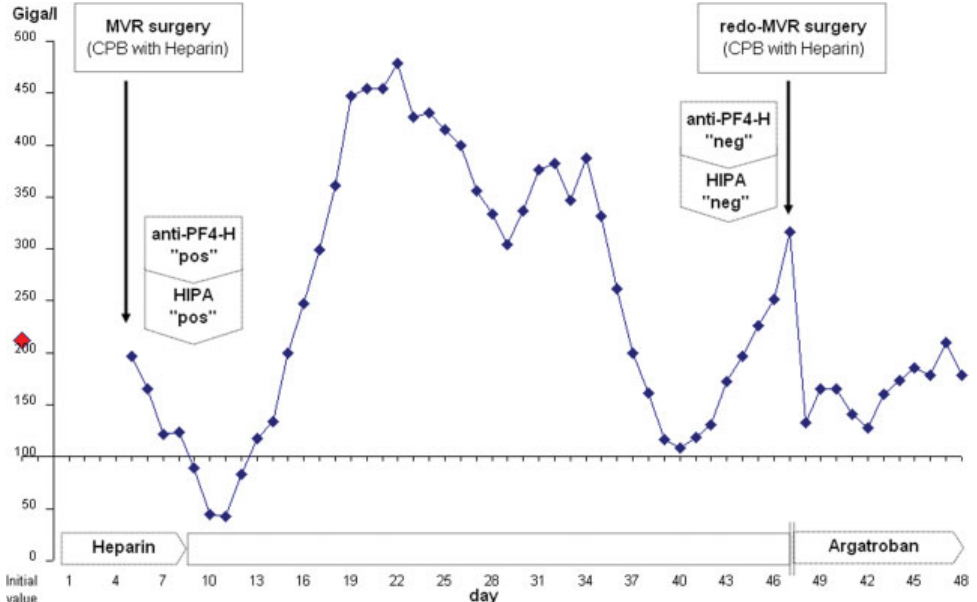
factor 4-heparin (anti-PF4-H) antibody test, based on a che- miluminescent assay (ACL, AcuStar), revealed positive results for both patients (2.44 U/mL in patient A, and 4.6 U/mL in patient B, cut-off value: (cid:1) 1.0 U/mL). The chemiluminescence